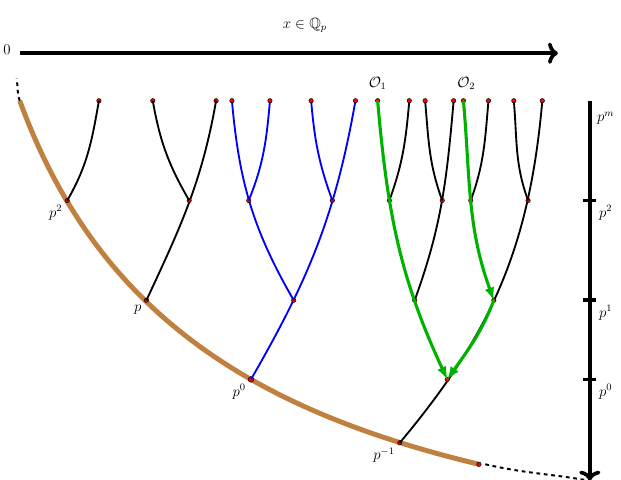
Figure 13. Pushing down the boundary operators to compute the two-point correlation function, shown for the 2-adic